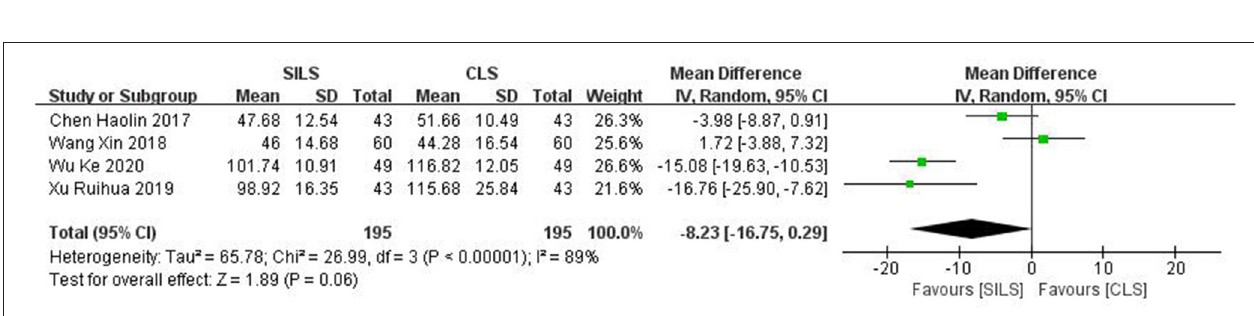
FIGURE 4 | Meta-analysis of length of abdominal incision. SILS, single-incision laparoscopic surgery; CLS, conventional laparoscopic surgery.